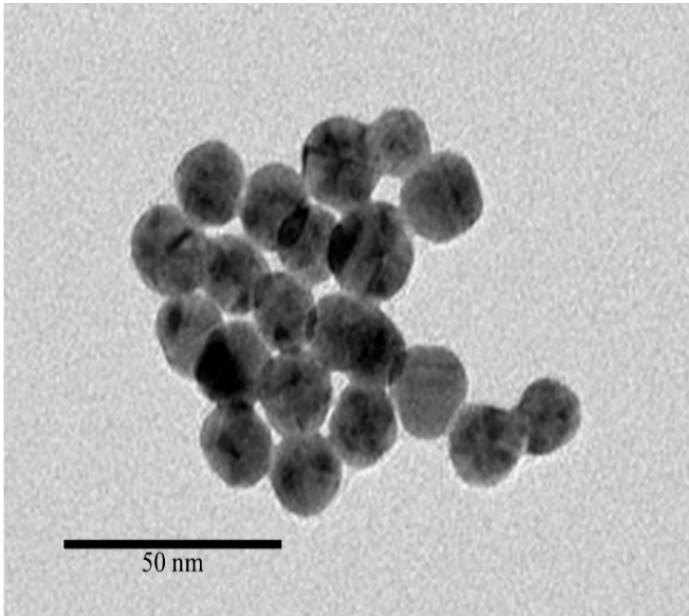
Figure 6. HR-TEM image of the aggregated stage of AuNPs.